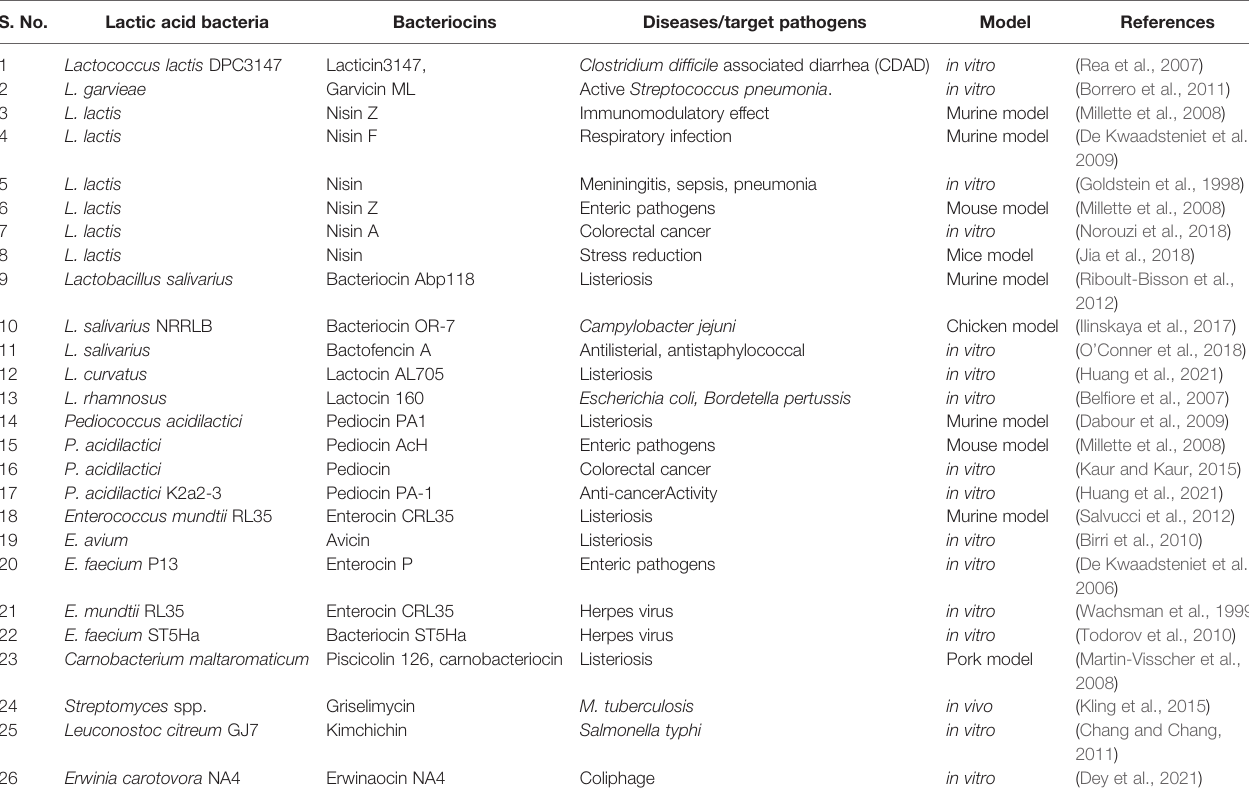
TABLE 1 | Bacteriocin-producing lactic acid bacteria involved in the modulation of gut microbiota and treatment/maintenance of different diseases. S.